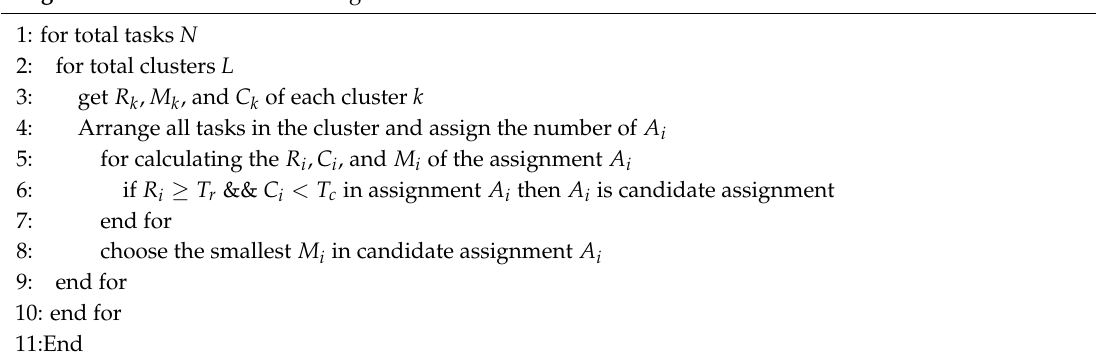
Algorithm 1. Cluster Selection Algorithm